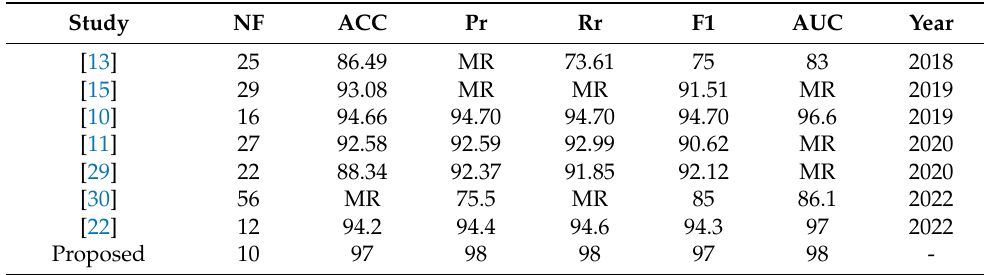
Table 5. Comparison of our proposed model with other contemporary performance models on the Z-Alizadeh Sani